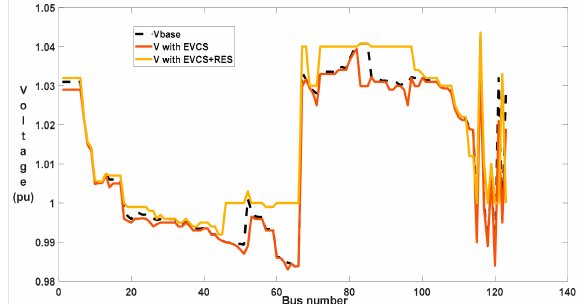
Figure 15. Voltage profile of IEEE 123 bus system.